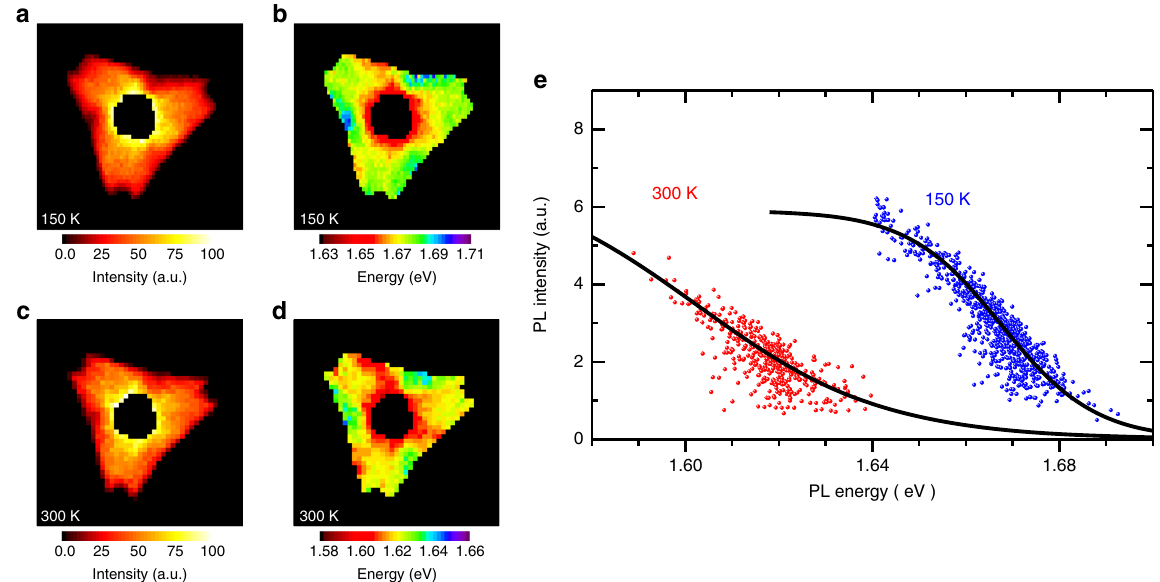
Fig. 4 PL intensity – energy correlations at different temperatures. a – d Contour color maps of PL intensity ( a , c ) and peak energy ( b , d ) in the WSe 2 region of a MoSe 2 – WSe 2 lateral HJ measured at different temperatures: ( a , b ) T = 150 K and ( c , d ) T = 300 K. e Integrated PL intensity as a function of peak energy measured at 150 K (blue dots) and 300 K (red dots). Black lines are model fi tting